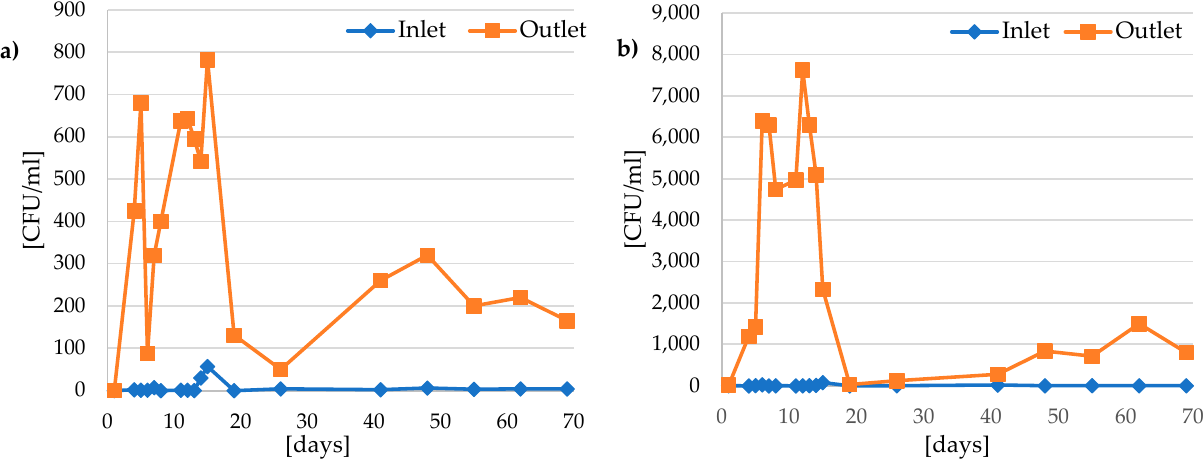
Figure 5. Microbiological quality of water in the inflow and outflow of the system: ( a ) bacteria growing at 37 °C, ( b ) bacteria growing at 22 °C (A agar).